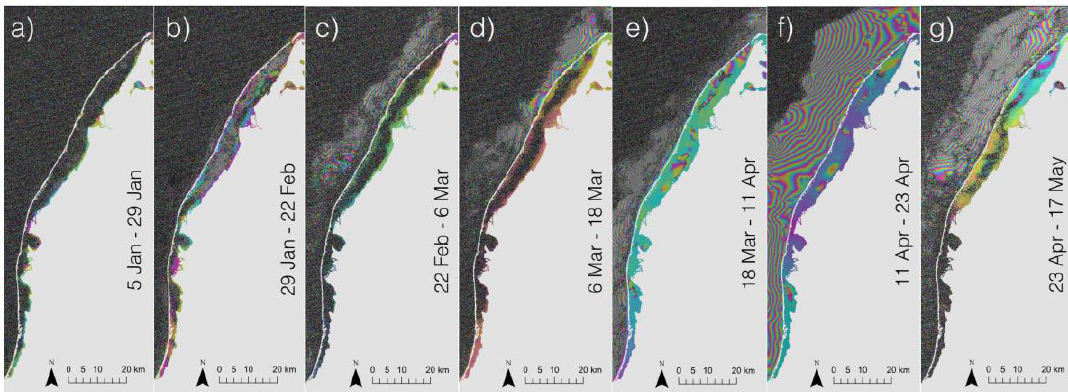
Figure 7. Bottomfast ice evolution in Kasegaluk Lagoon as interpreted through the phase signature of Sentinel-1 interferograms during winter and spring 2017. The individual panels represent time